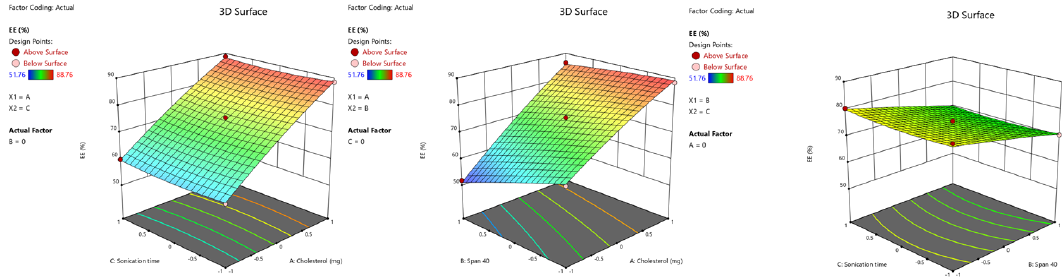
Figure 2. 3D surface response plots of the e ff ect of independent variables on EE